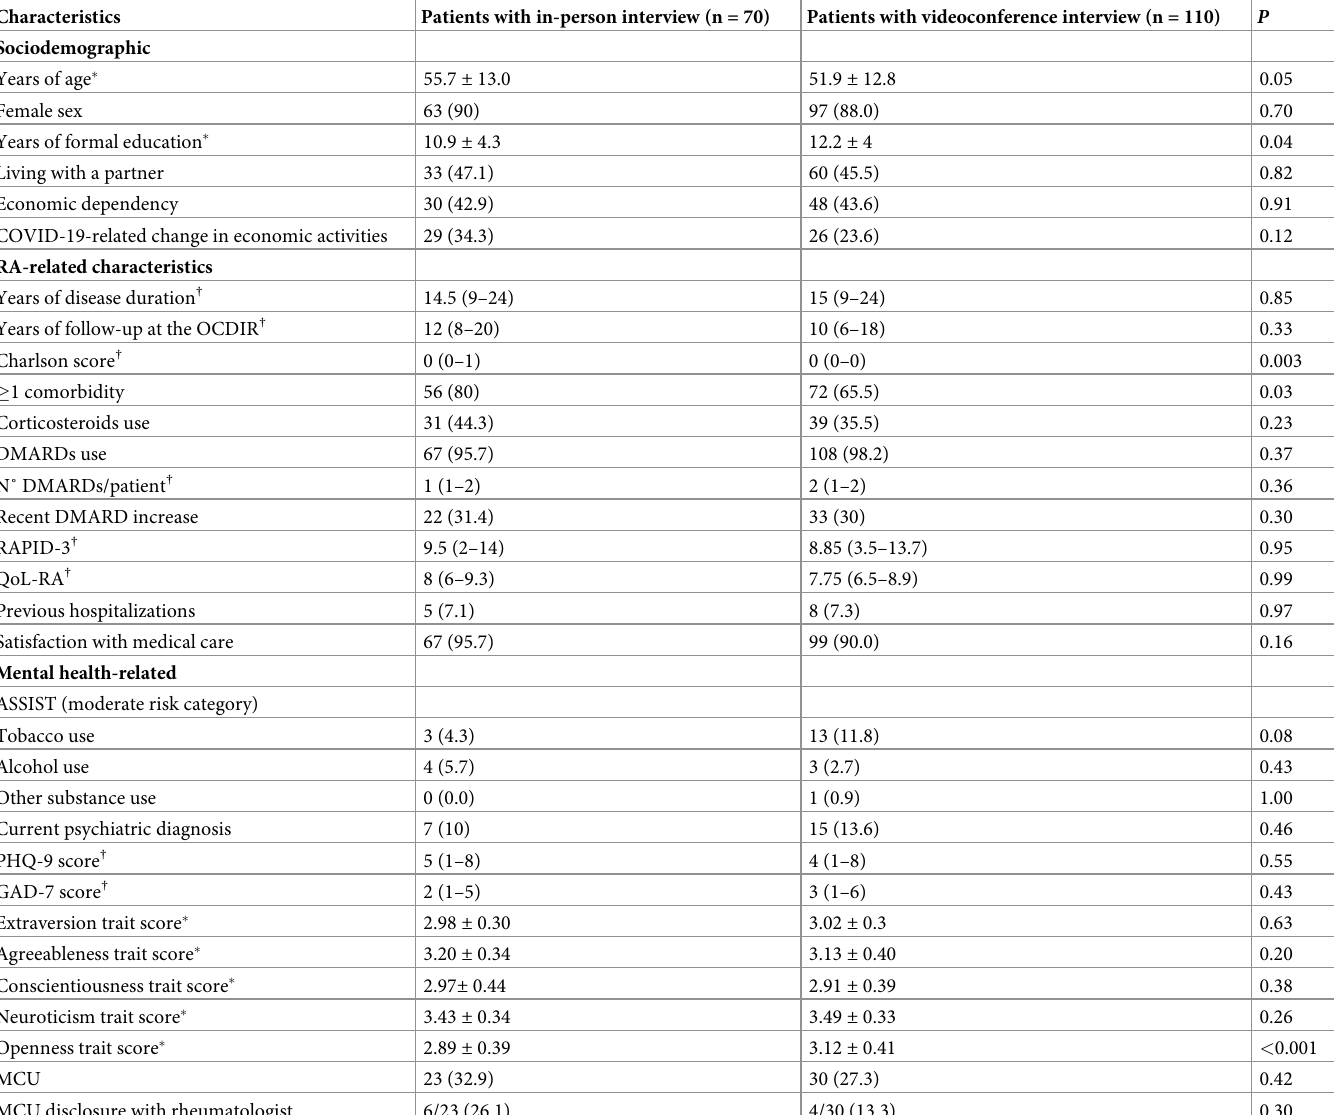
Table 2. Comparison of characteristics between patients with in-person and videoconference interview.